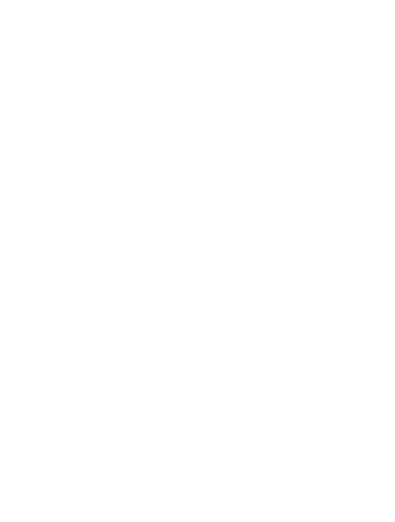
Table 1. Baseline characteristics of 35 HCC